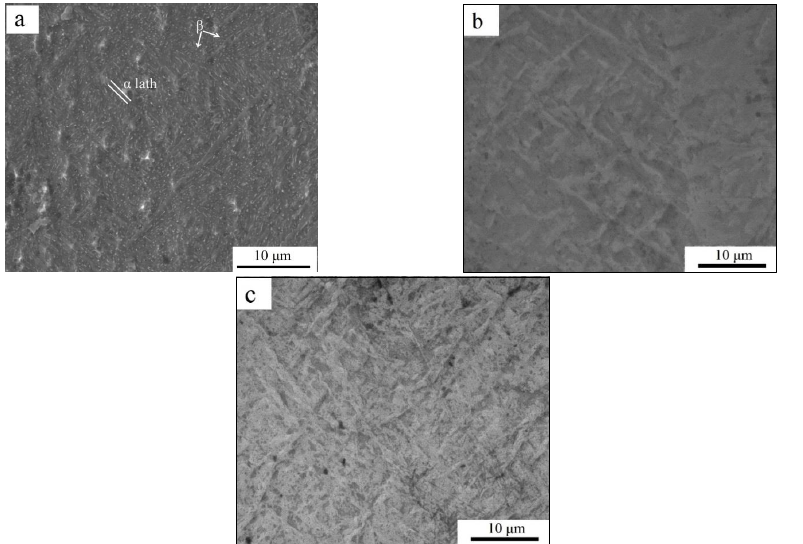
Figure 1. SEM images of electron beam melting (EBM) Ti-6Al-4V alloys: as-built samples ( a ), after pulsed ion beam (PIB) exposure (mode 1) ( b ), after PIB exposure (mode 2) ( c ).